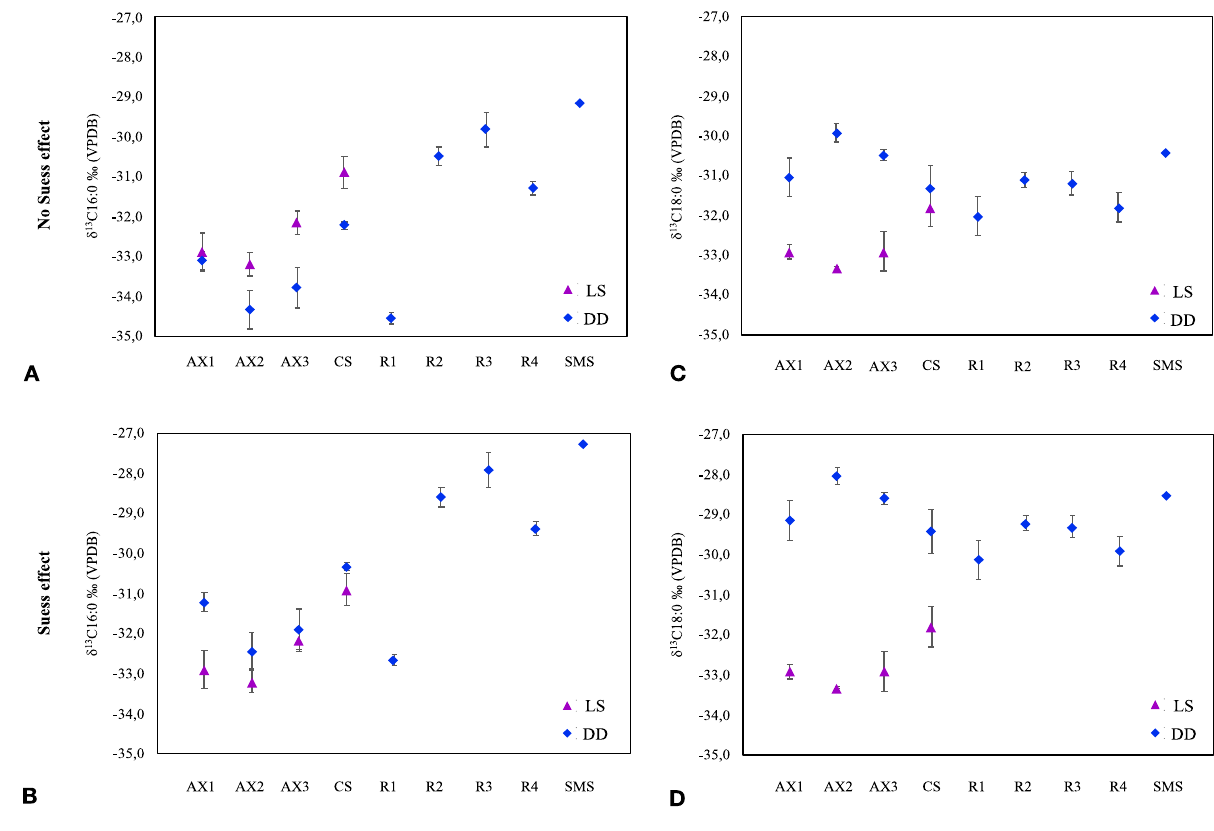
Figure 2. δ 13 C 16:0 and δ 13 C 18:0 values from Axlor, Crvena Stijena LS and DD samples, Cape Espenberg DD and resin control samples. ( A ) δ 13 C 16:0 before Suess effect correction; ( B ) δ 13 C 18:0 before Suess effect correction; ( C ) δ 13 C 16:0 after Suess effect correction and ( D ) δ 13 C 18:0 after Suess effect correction.